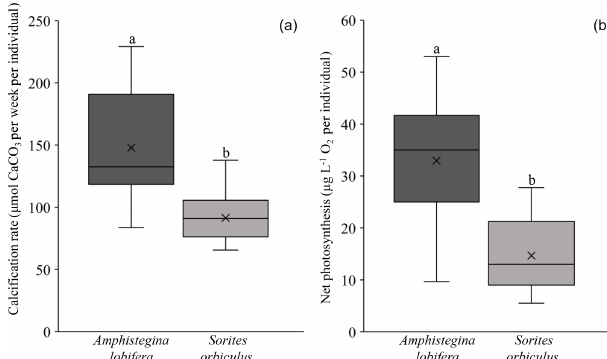
Figure 2. Activity baseline of the foraminiferal calcification rate (a) and symbionts’ net photosynthesis (b) of A. lobifera ( n = 14, 15) and S. orbiculus ( n = 15, 15). Note the significant differences in baseline values of both calcification rates ( p < 0 . 001) and photo- synthetic activity ( p < 0 . 001) between the two holobionts. Error bars represent minimum and maximum